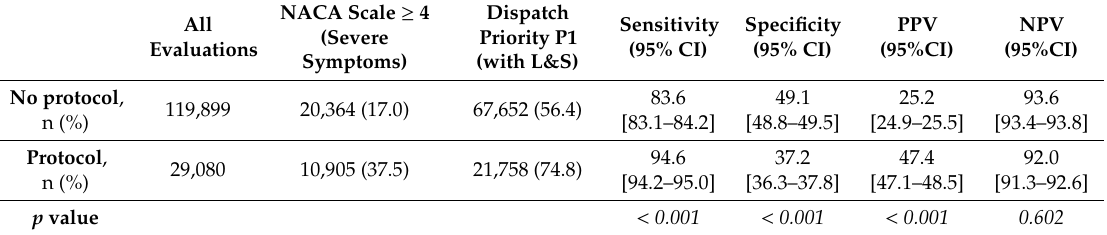
Table 2. Impacts of the protocols on the accuracy on the